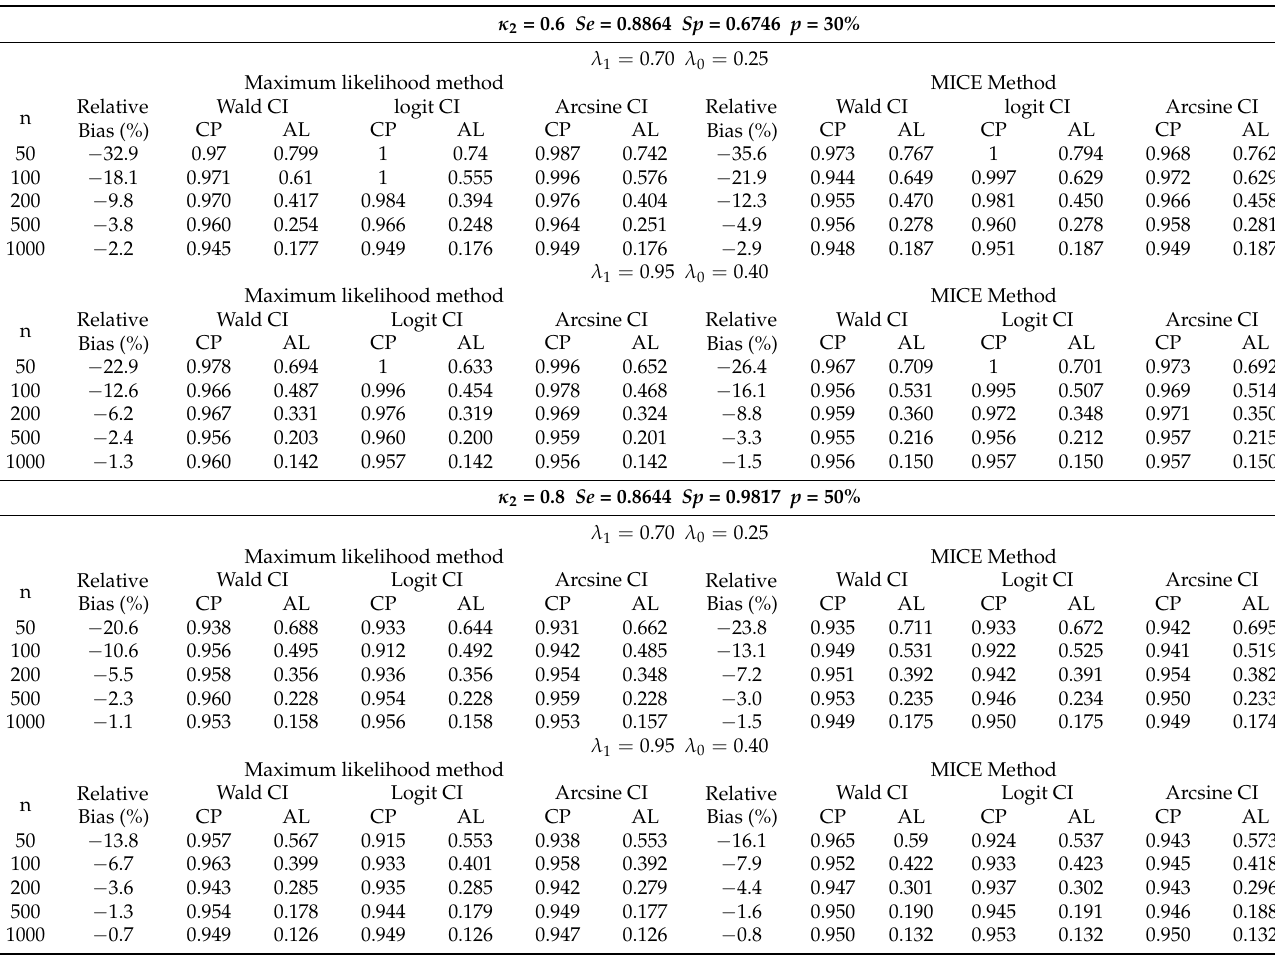
Table 6. Coverage probabilities and average lengths of CIs for κ 2 = { 0.6,0.8 }